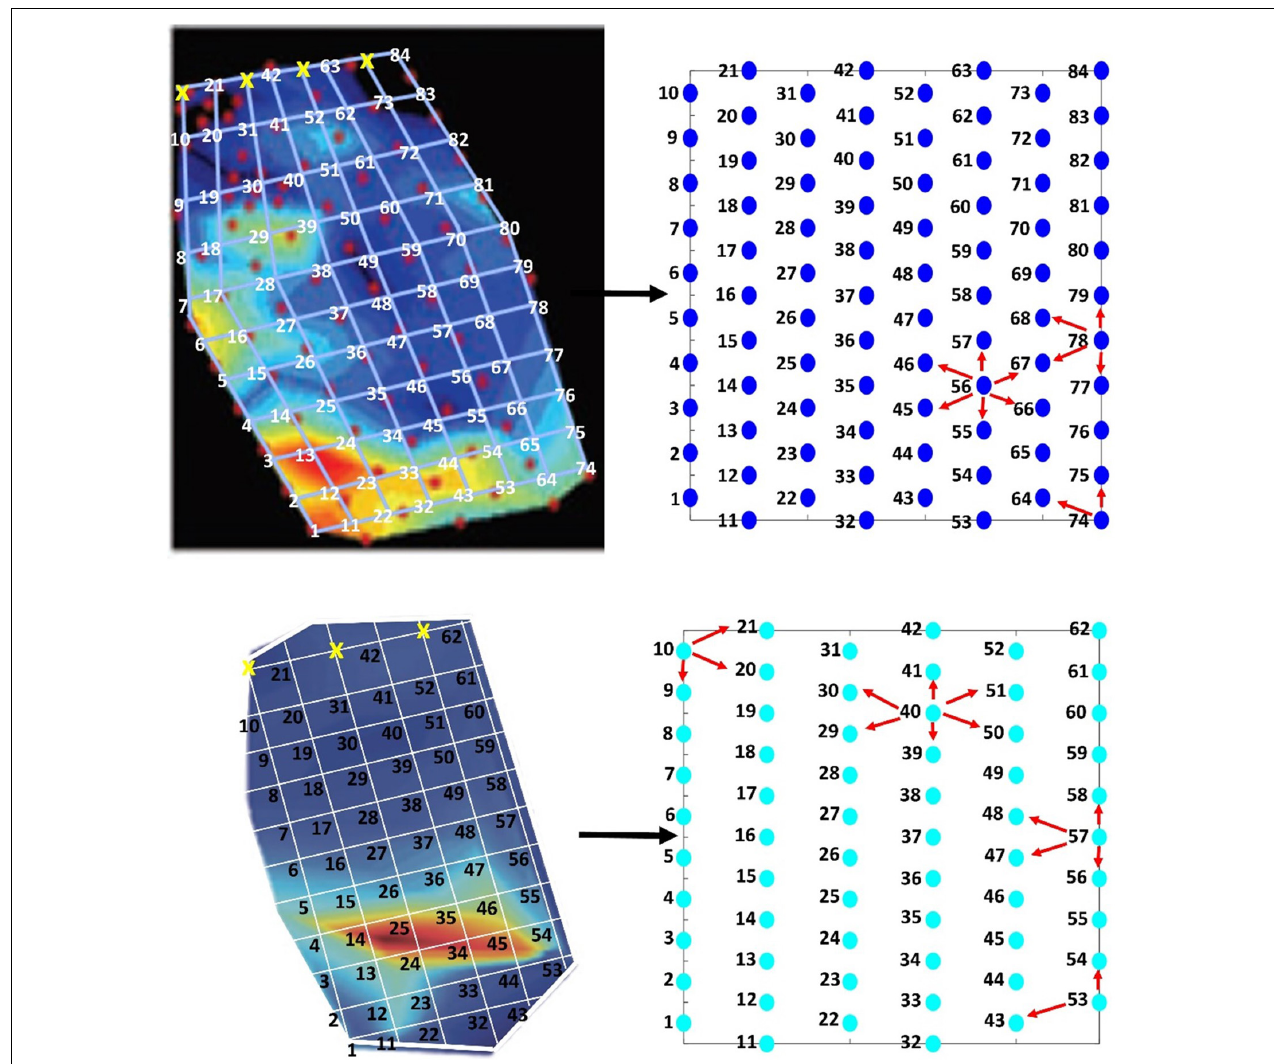
FIGURE 6 | Schematic of how the data were extracted from the heat maps in the original studies (left figures) –AUTEC (top) and PMRF (bottom) —and mapped onto the mock hydrophone arrays (right figures). For this study the white grid lines were added to each of the analysis period data images in Figure 5 . The values at the grid intersections were extracted to create the exemplar data sets. Gridlines marked by a yellow “x” indicate values that were not extracted. Each circle on the right represents the location of a hydrophone on the mock arrays. The numbers in the left figures correspond to the same number in the right figures and show where the value on the heat map was extracted from and to. In addition, the right figures provide examples of adjacent neighbor assignments for each of the hydrophone array layouts. Red arrows point to hydrophones that would be considered an adjacent neighbor to the respective hydrophone centered within the